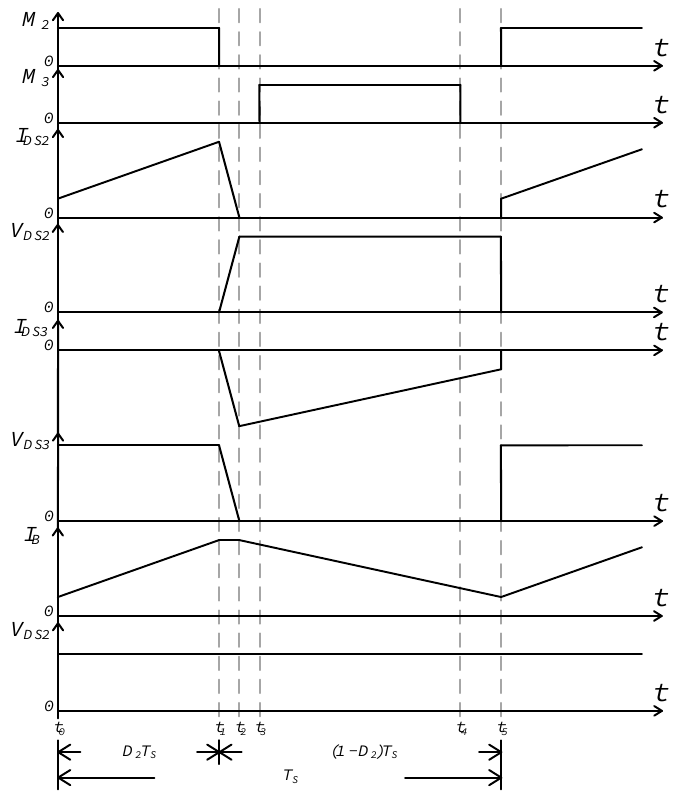
Figure 8. Conceptual waveforms of each operational mode of the proposed hybrid converter operated in the PV arrays source condition over a complete switching cycle.